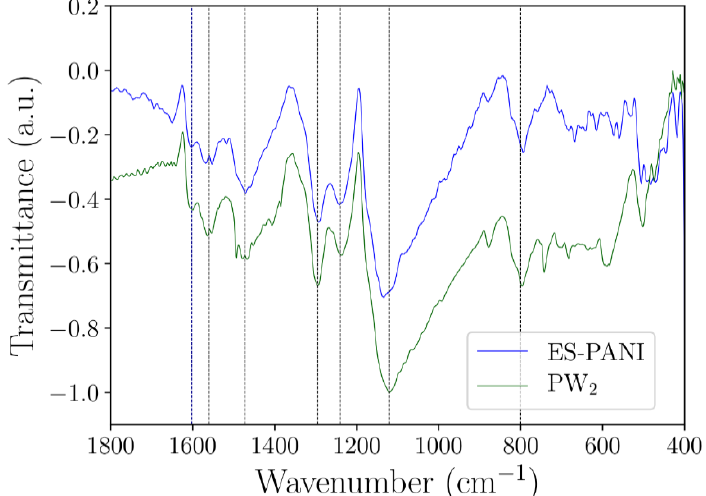
Figure 5. FTIR spectra of ES–PANI and PW 2 nanocomposite.